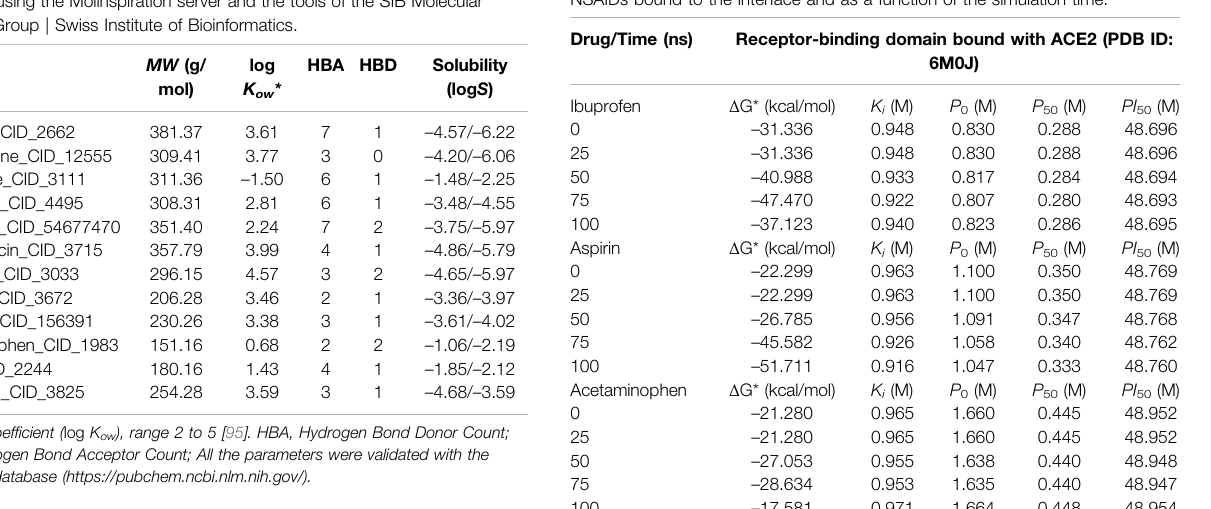
TABLE 4 | Results of the binding energy and amount of free protein assuming a competitive inhibition of the RBD-ACE2 complex in the presence of the NSAIDs bound to the interface and as a function of the simulation time.